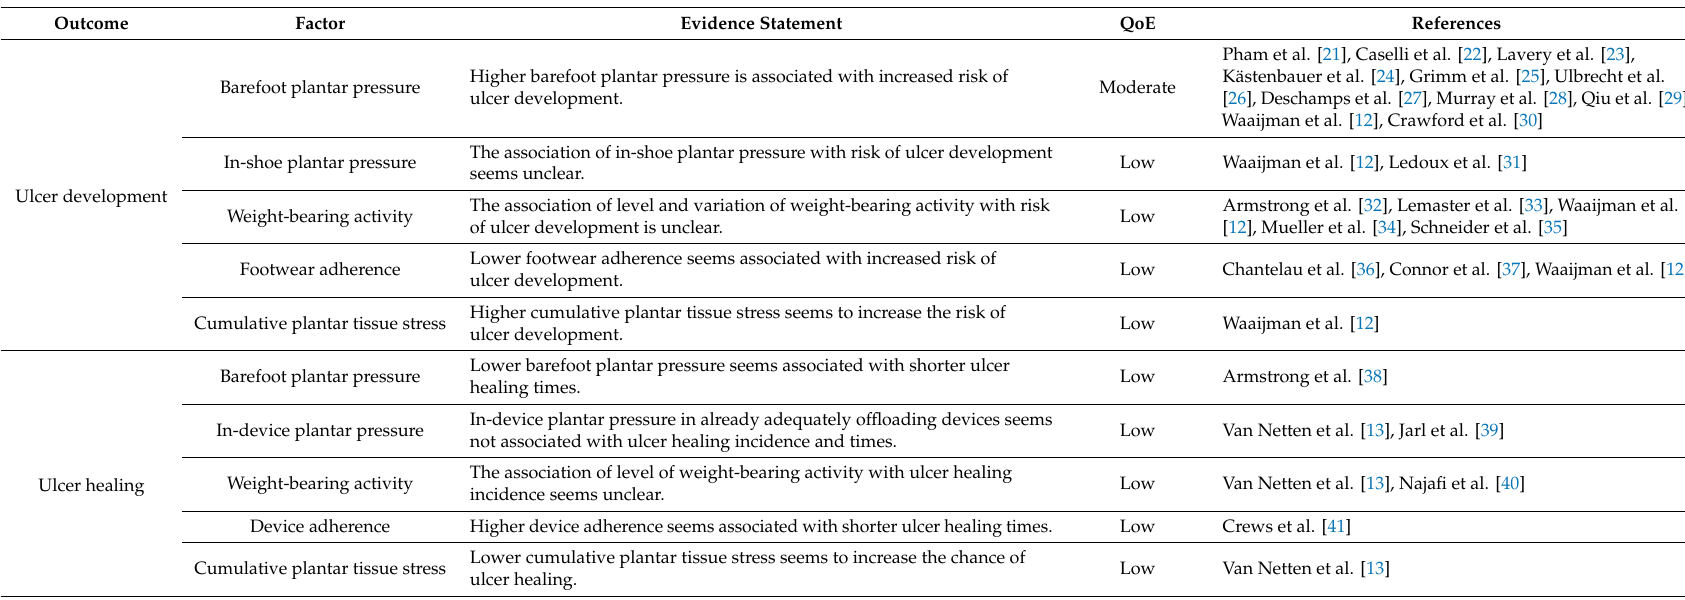
Table 1. Evidence statements and quality of evidence (QoE) for the associations between foot-loading factors and ulcer development and ulcer healing.